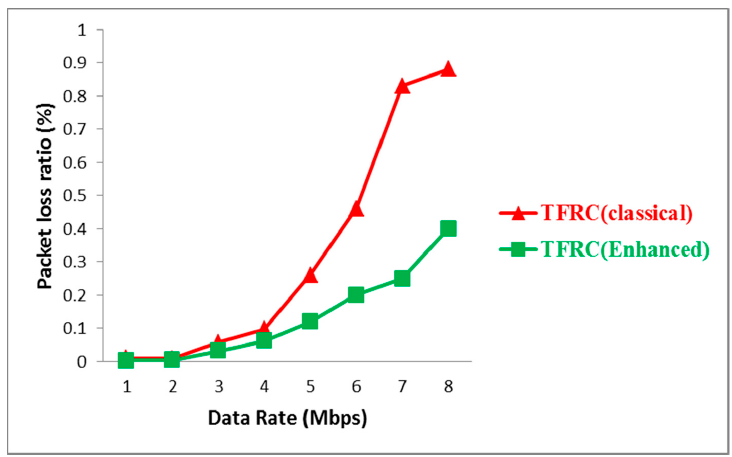
Figure 4. Comparison of packet loss ratio between classical TFRC and Enhanced TFRC.